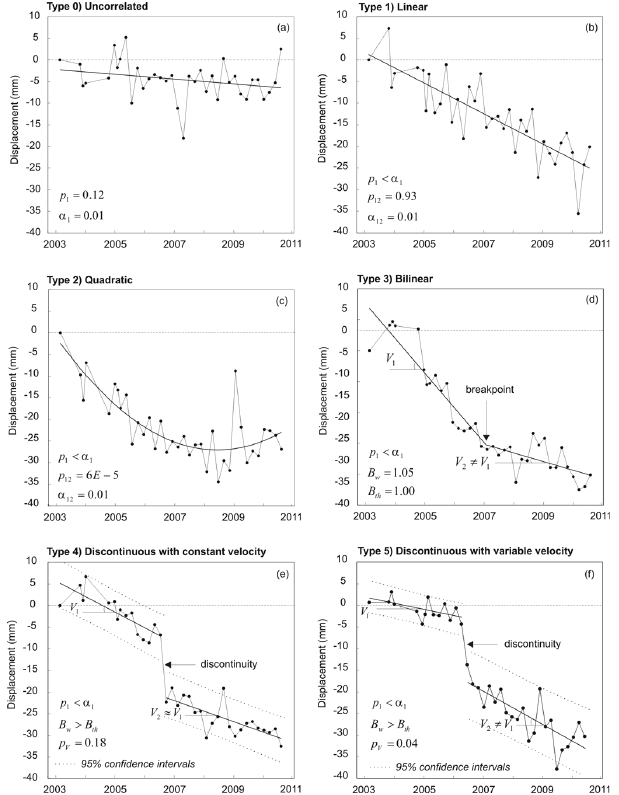
Fig. 1. Typical ground displacement trends identified by visual in- spection of 1000 Permanent Scatterers time series. Letters indi- cate the results of the automatic classification obtained by statistical analyses (see text and Fig. 2).